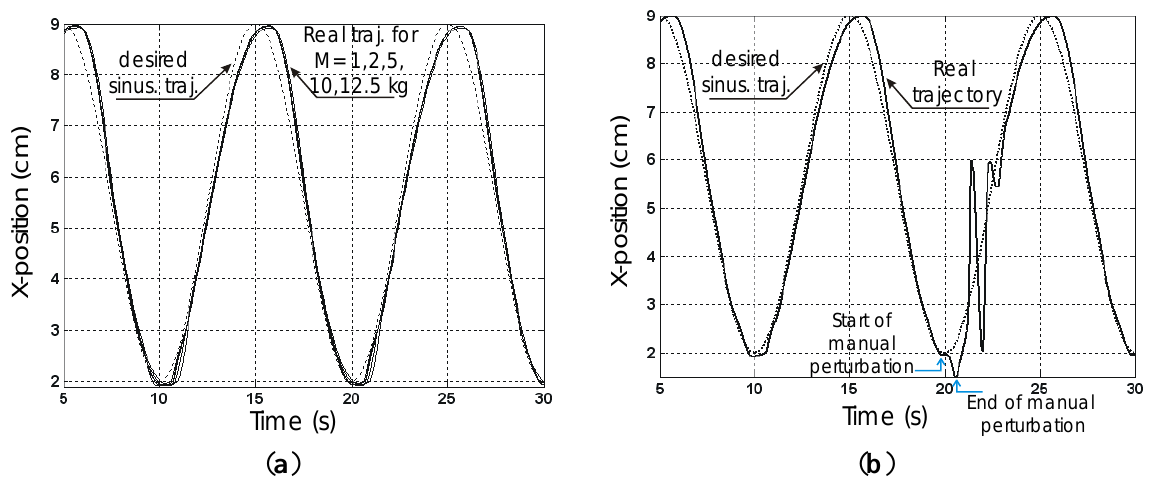
Figure 9. Sinus-wave tracking at a 0.1 Hz operating frequency in the case of the rayon yarn-braided McKibben muscle ( a ) and ( b ) Effect of a manual perturbation during closed-loop control